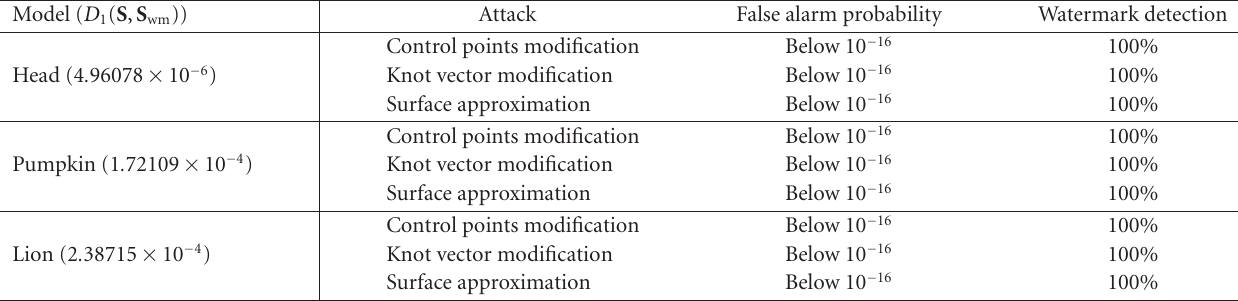
Table 4: Resilience against three